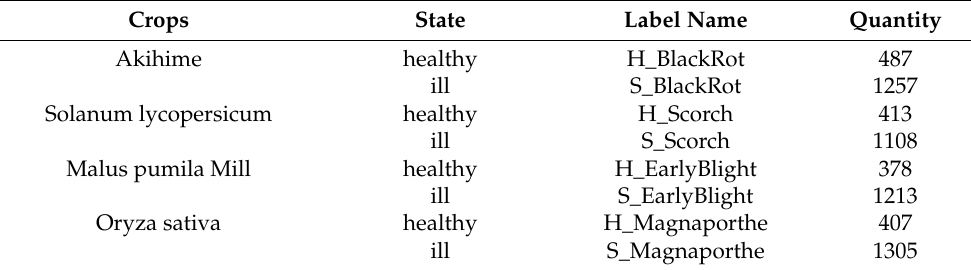
Table 1. Crop data